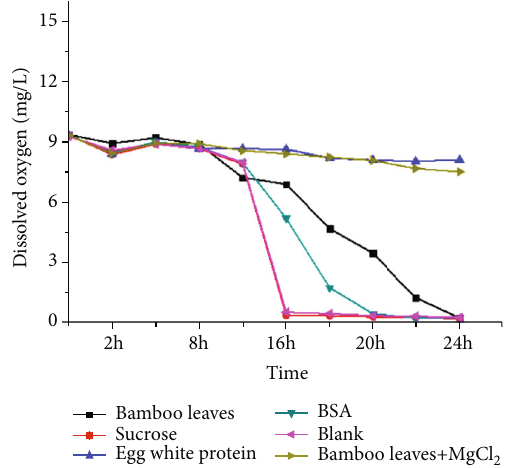
Figure 6: Change chart of dissolved oxygen.